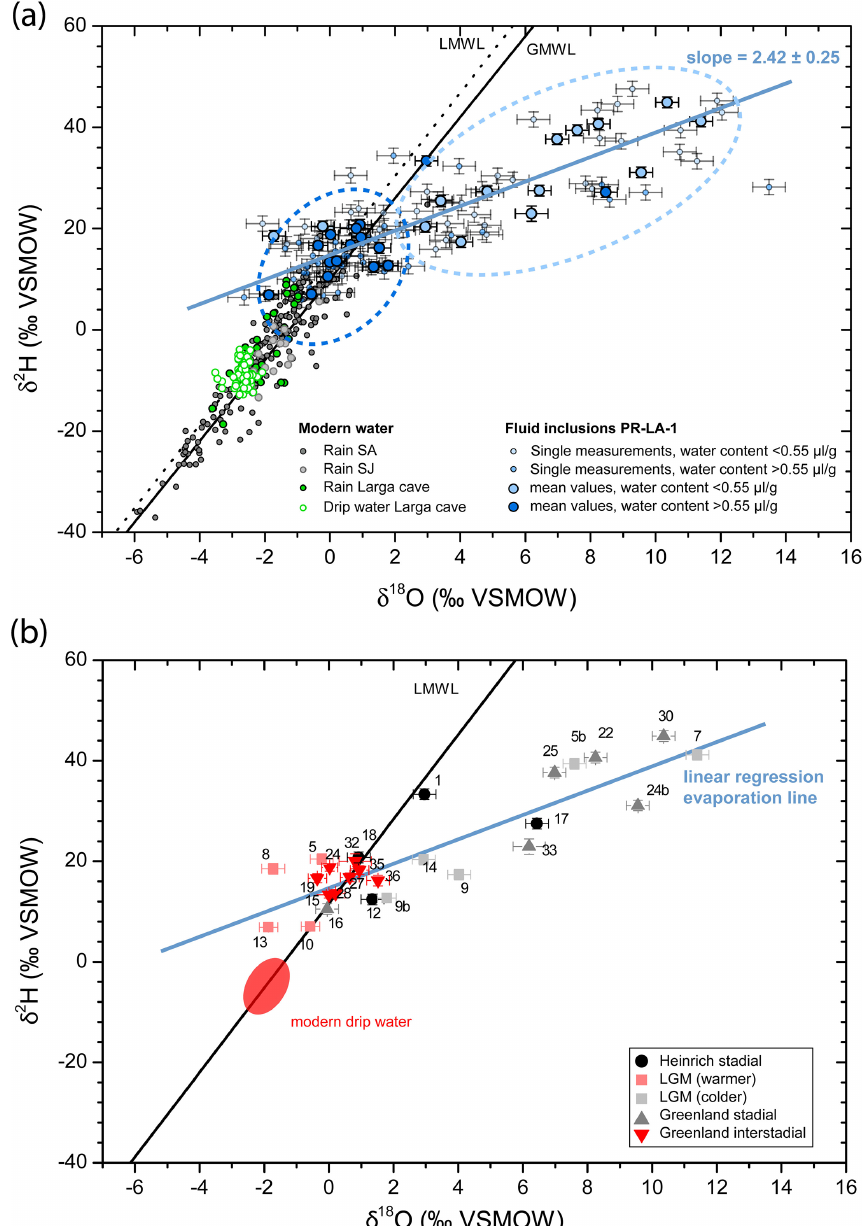
Figure 3. (a) Results of stable isotopes of fluid inclusions and drip waters in Larga Cave as indicated in Tables S1 and S2. Lines indicate the GMWL and the LMWL with δ 2 H = 8.2 × δ 18 O + 14‰ VSMOW by Scholl and Murphy (2014). Single values of the water isotopes in fluid inclusions (small circles) and mean values (large circles) with corresponding standard deviation are shown together with Larga Cave drip water from different drip sites (2013–2019, green triangles) and local rainwater data (compare Fig. 1). The mean values of the replicate measurements are allocated to two groups, with cluster (1) comprising samples on or scattering around the GMWL (indicated by the dark blue circle), and cluster (2) comprising all samples with a clear evaporation signal, plotting off the GMWL (light blue circle). (b) Stable isotope values of fluid inclusions from stalagmite PR-LA-1, categorized according to their allocation to the presumably warm (interstadial) or cold (stadial) periods when they formed. Thereby, a distinction is made between Heinrich stadials, Greenland stadials, and Greenland interstadials. Analysed samples from the LGM are also subdivided into presumably more warm/humid and relatively cool/dry periods. Numbers refer to the sample IDs as shown in Tables S1 and